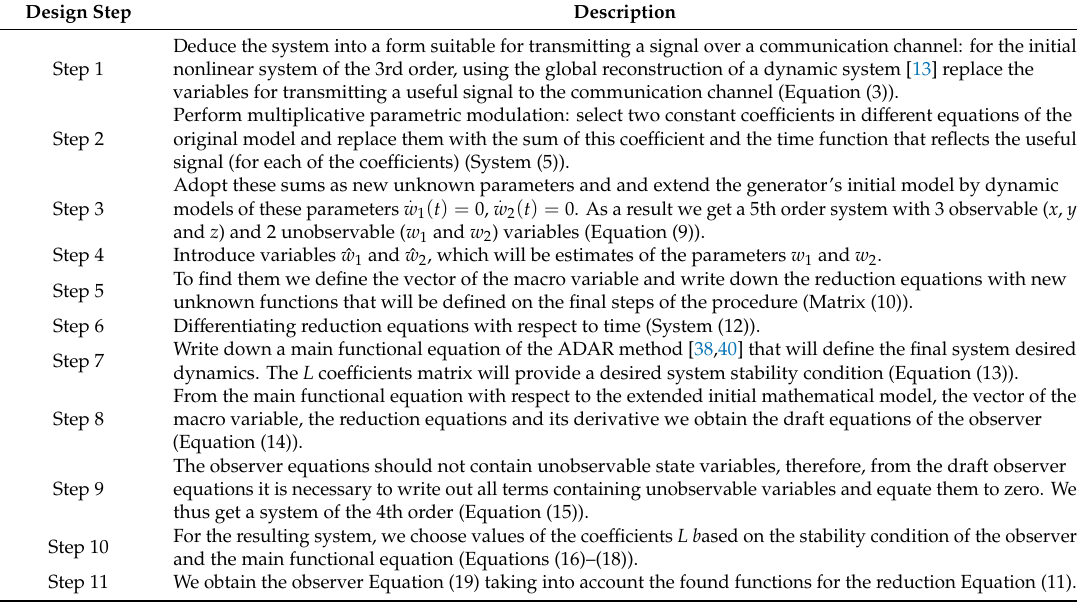
Table 2. Example of steps for our synergetic observer design procedure for Rössler